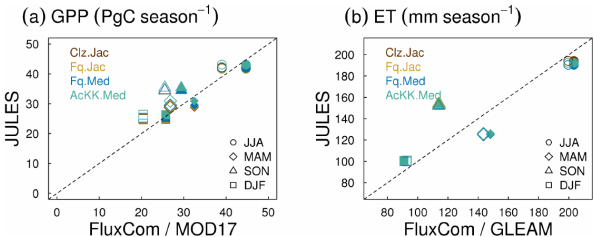
Figure 3. Seasonal mean global (a) GPP and (b) ET for each JULES model configuration compared to FluxCom (closed symbols) and MOD17 (GPP) or GLEAM (ET) (open